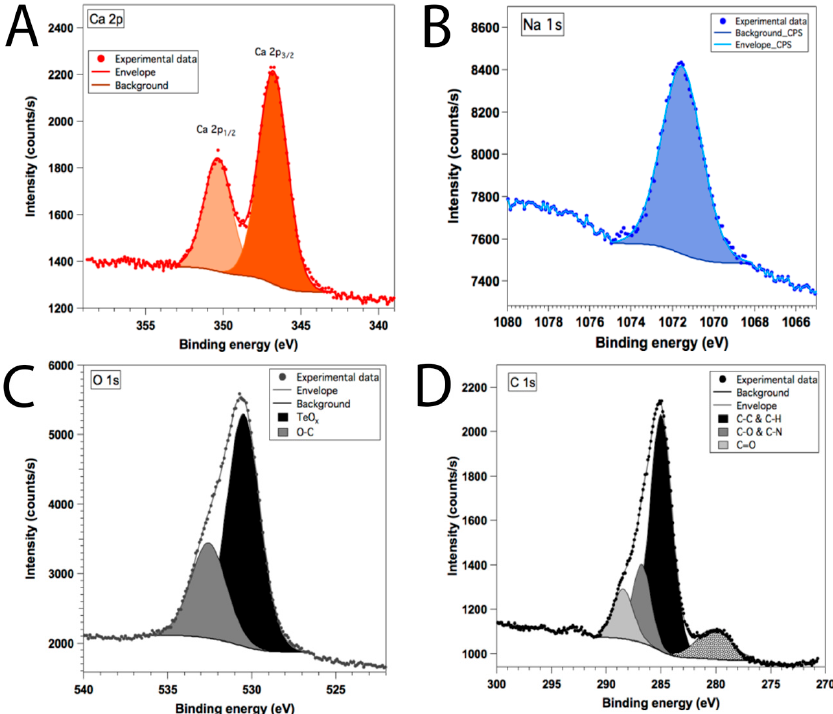
Figure A6. Ca 2p XPS core level spectrum ( A ), Na 1s XPS core level spectrum ( B ), O 1s XPS core level spectrum and the corresponding components used in the fitting procedure ( C ), and C 1s XPS core level spectrum and the corresponding components used in the fitting procedure ( D ).